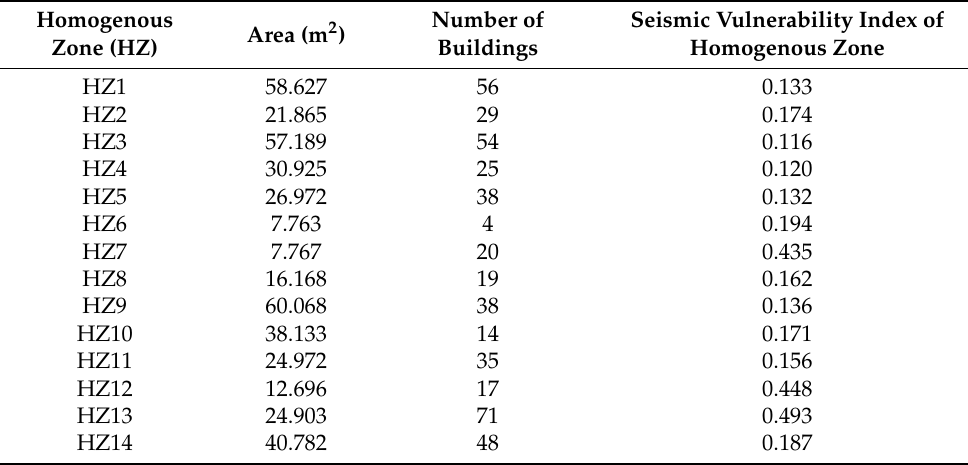
Table 2. The basic data of homogenous zones and average seismic vulnerability index.